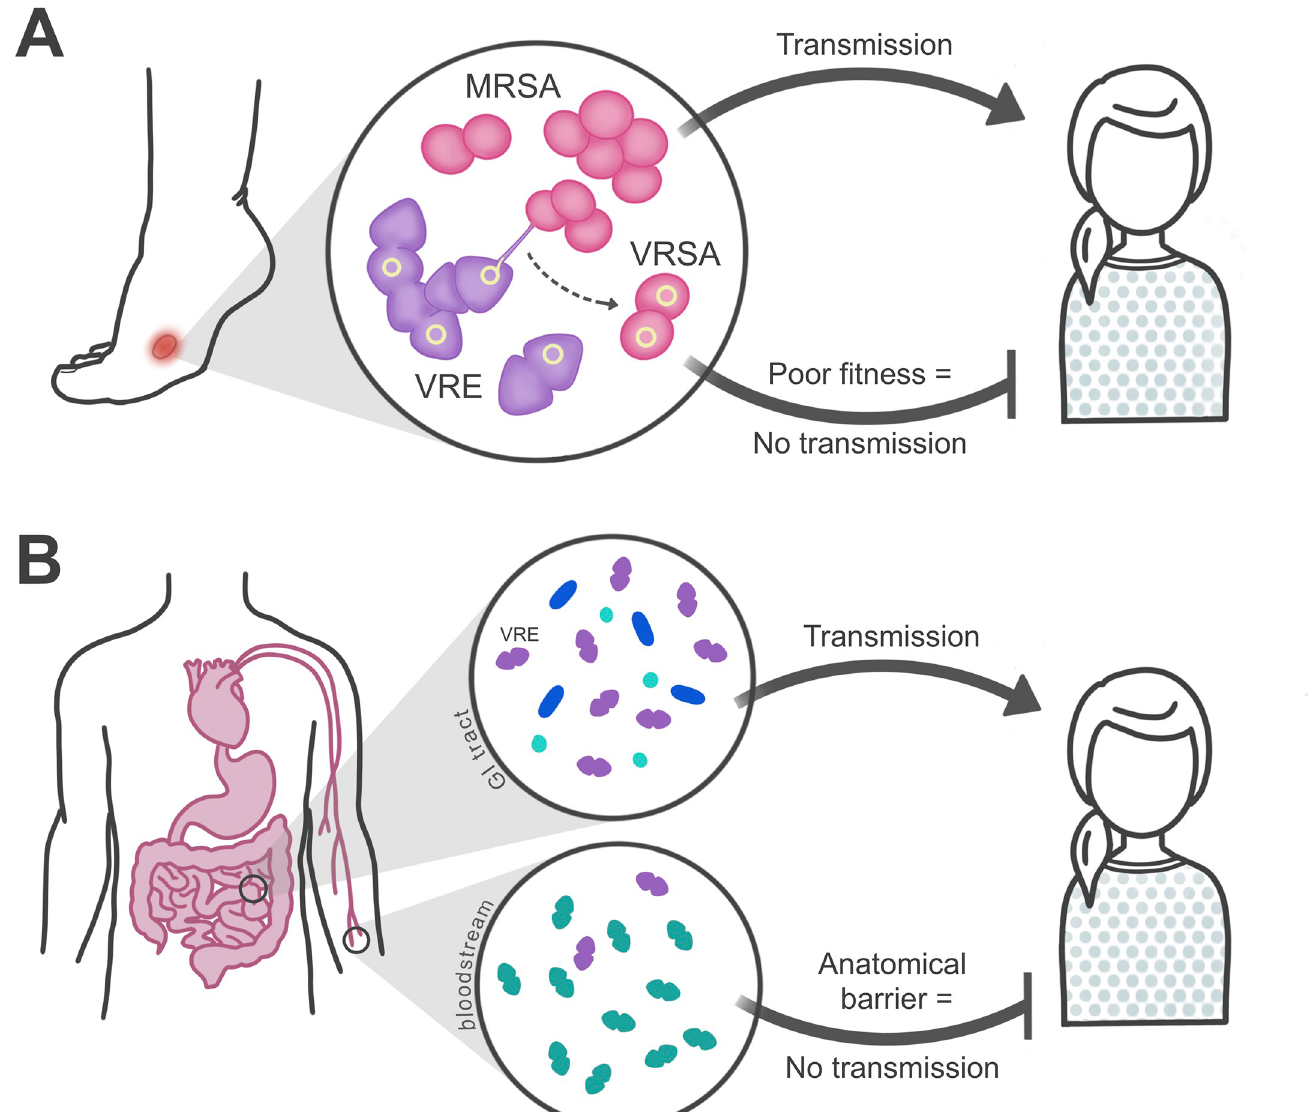
Fig 3. Bacterial evolution during acute infection. (A) Evolution of VRSA during coinfection with MRSA and VRE. While MRSA can be easily transmitted to other patients, VRSA have poor fitness and cannot be transmitted. (B) Different VRE populations in the GI tract and bloodstream of an infected patient. While VRE from the GI tract can be transmitted to other patients, VRE infecting the bloodstream are not transmitted. Conditionally beneficial mutations (shown in green) that are selected during growth in the bloodstream will similarly not be transmitted to other patients. Because anatomical barriers prevent conditionally beneficial adaptations from being transmitted, body sites such as the bloodstream can be considered evolutionary “dead-ends.” GI AU : AnabbreviationlisthasbeencompiledforthoseusedinFig 3 : Pleaseverifythatallentriesarecorrect : , gastrointestinal; MRSA, methicillin-resistant S . aureus ; VRE, vancomycin-resistant Enterococcus ; VRSA, vancomycin-resistant S . aureus .